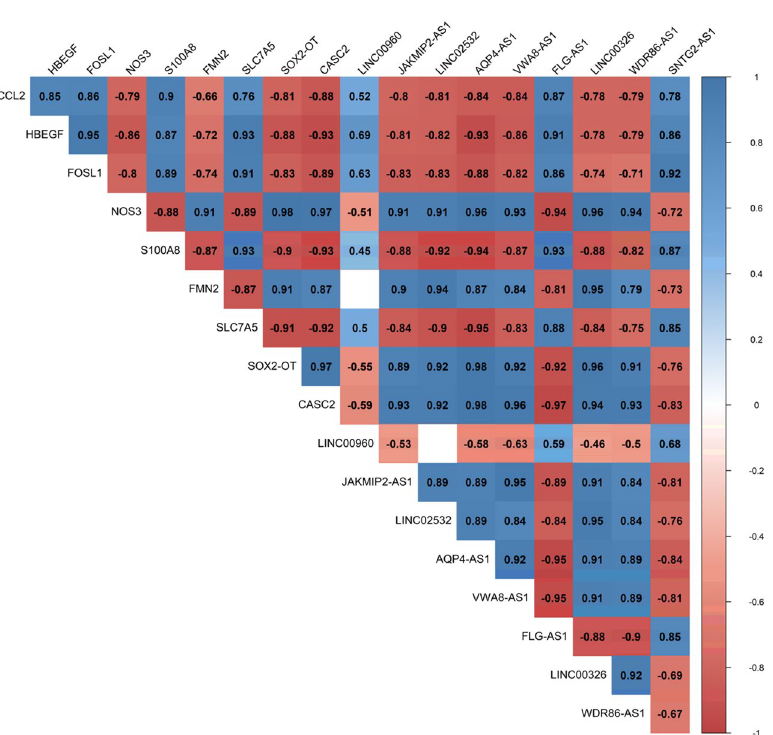
Figure 3. Positive correlations are shown in blue, while negative correlations are shown in red. The intensity of the colors is related to correlation coefficients, and the ones with a P value greater than 0.001 are deemed insignificant. Note that values of correlation coefficients are left blank in this situation. This figure was made using Hmisc and corrplot packages of R version 4.0.3 (https:// www.r- proje ct.